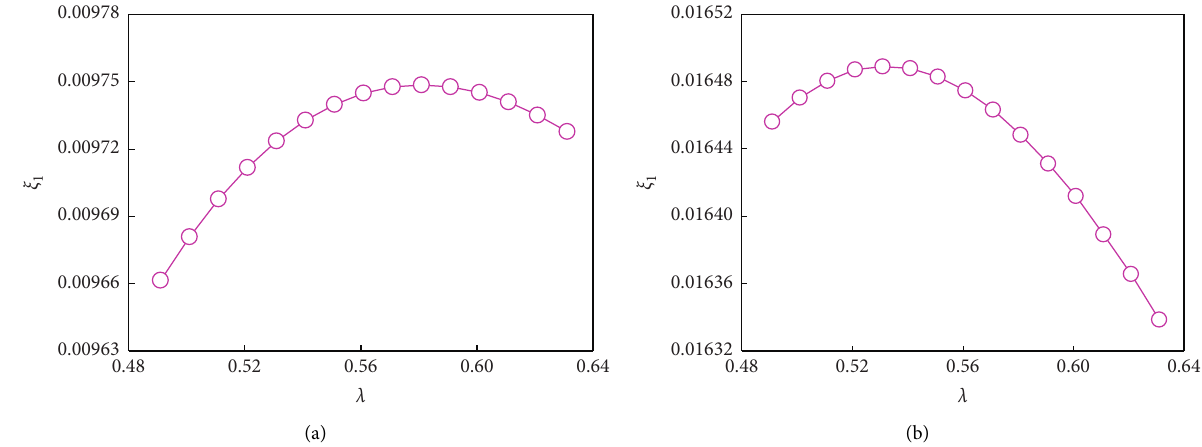
Figure 12: Variations of the first additional modal damping ratio ξ analysis method.